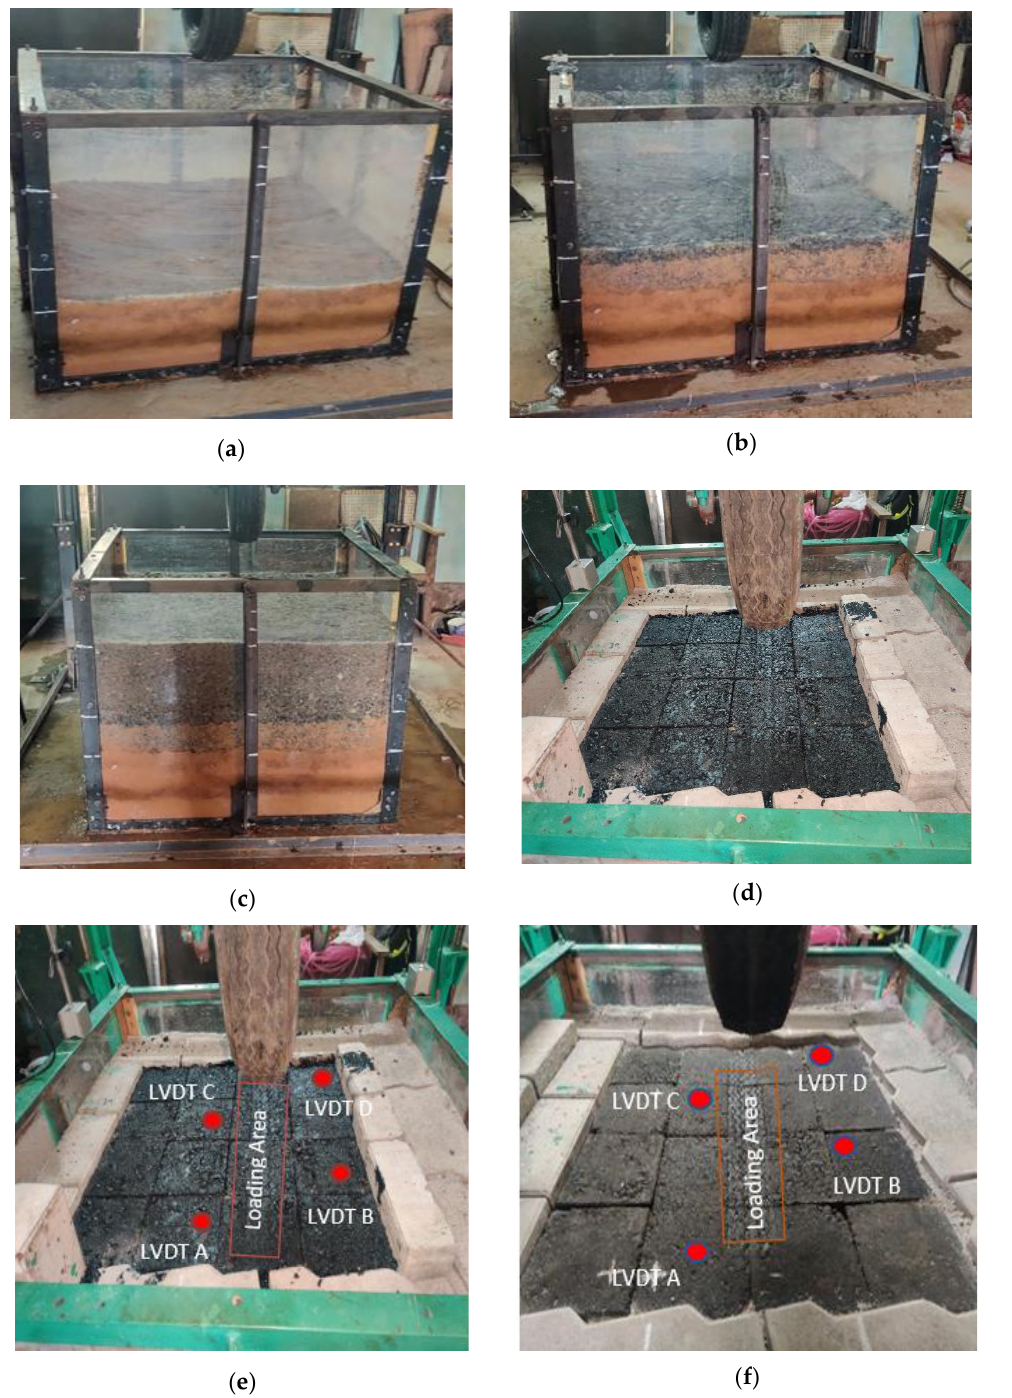
Figure 7. Bituminous block pavement setup ( a ) subgrade (300 mm thick); ( b ) sub-base (150 mm thick); ( c ) base course (250 mm thick); ( d ) bituminous block (55 mm thick); ( e ) loading over the center; ( f ) loading over the middle.